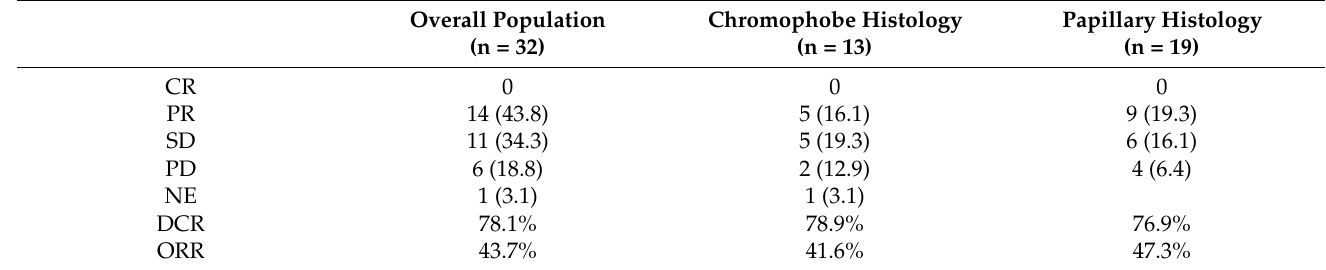
Table 2. Radiological Response in overall population and according to different histologies.